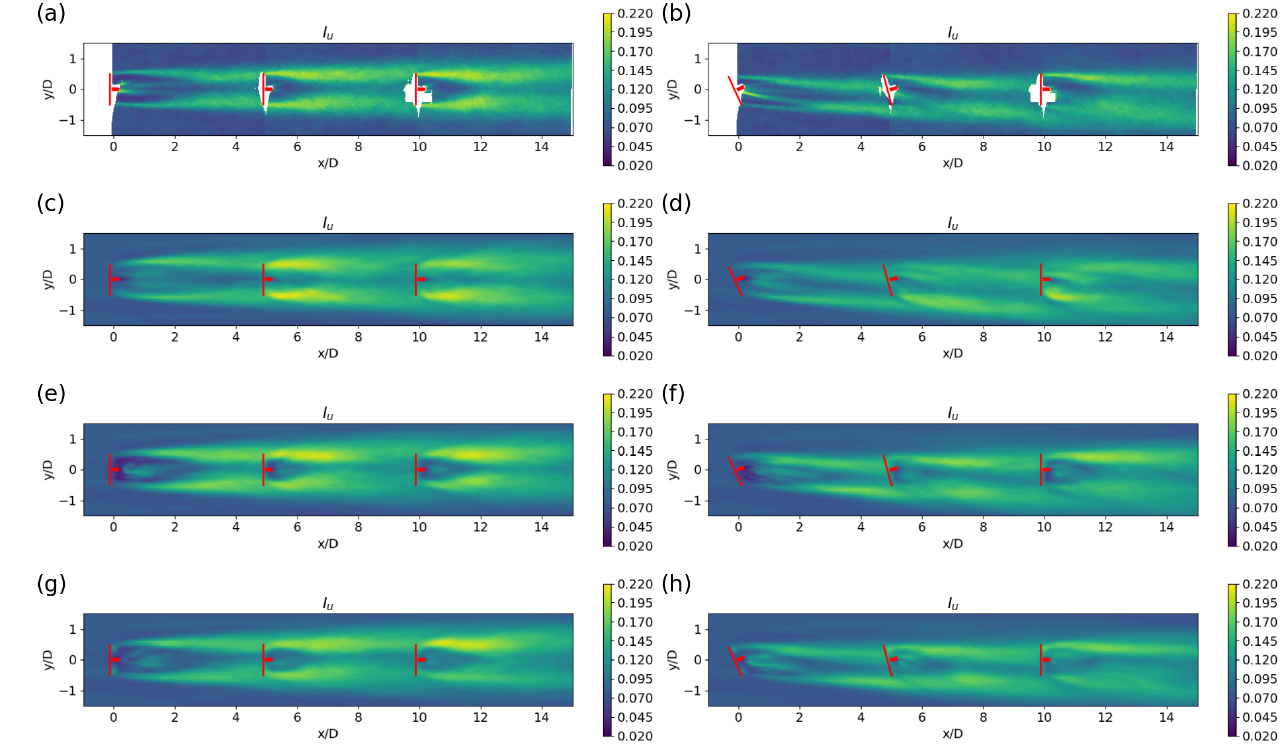
Figure 10. Top-view contours of the turbulence intensity I u in the x − y plane at hub height obtained from the wind-tunnel experiments and LES using the ADM-std, ADM-BE and ALM. The lateral offset of the turbines is zero (Cases 1 and 2). (a) Experiment, γ = (0 , 0 , 0 ◦ ); (b) experiment, γ = (25 , 15 , 0 ◦ ); (c) the ADM-std, γ = (0 , 0 , 0 ◦ ); (d) the ADM-std, γ = (25 , 15 , 0 ◦ ); (e) the ADM-BE, γ = (0 , 0 , 0 ◦ ); (f) the ADM-BE, γ = (25 , 15 , 0 ◦ ); (g) the ALM, γ = (0 , 0 , 0 ◦ ); (h) the ALM, γ = (25 , 15 , 0 ◦ ).